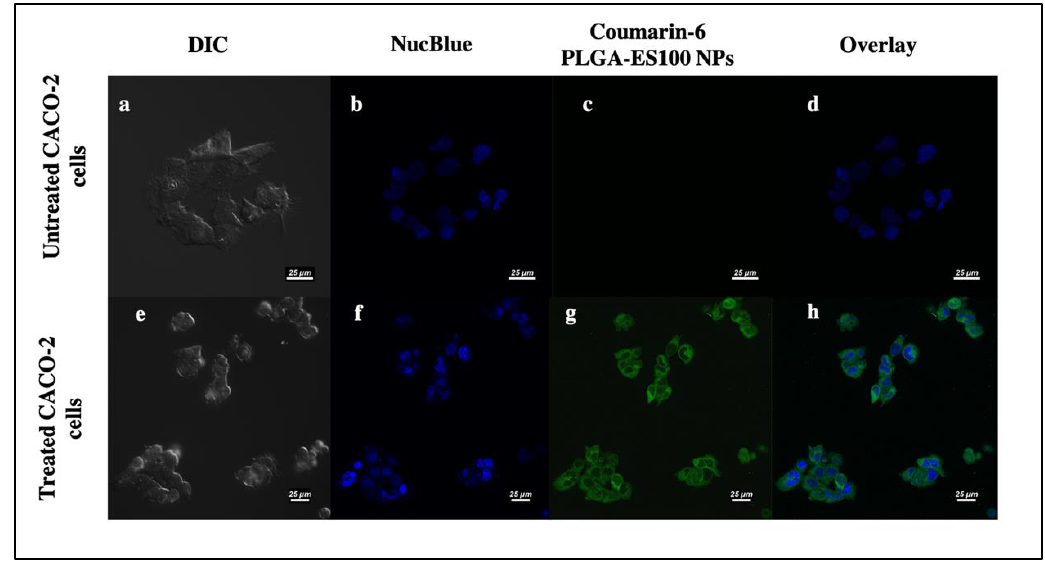
Figure 4. Cellular uptake of Coumarin-6 PLGA-ES100 NPs in CACO-2 cells by confocal microscopy; untreated CACO-2 cells ( a – d ), CACO-2 cells treated with Coumarin-6 PLGA-ES100 NPs for 4 h ( e – h ) (on a scale of 25 μm).